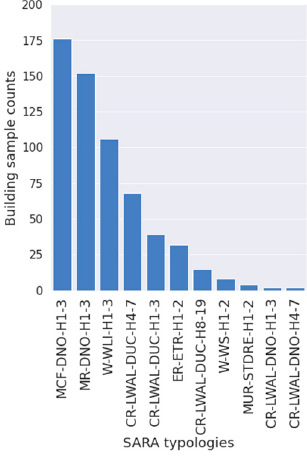
Figure A6. Resulting fuzzy compatibility scores for the building in Figure A4 with respect to the SARA typologies. The solid and dashed segments represent the equivalent defuzzified values according to the mode, median, or mean values of the triangular fuzzy numbers.